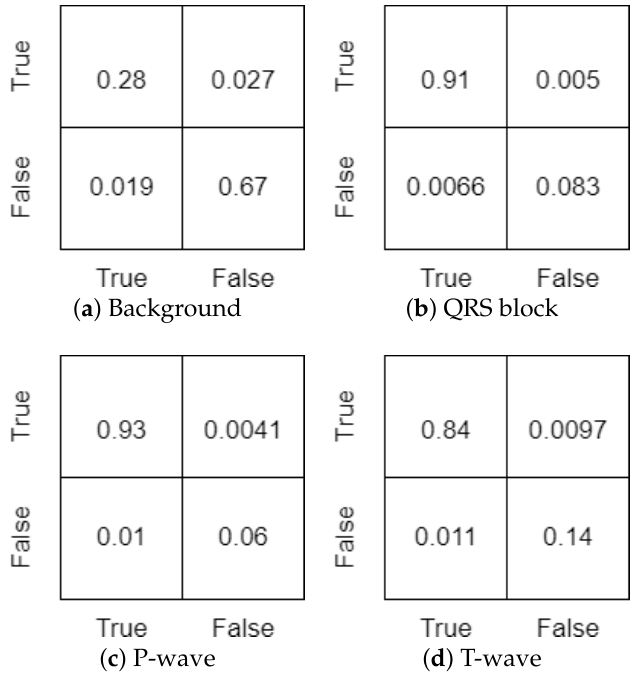
Figure 9. Confusion matrices for each class for the test